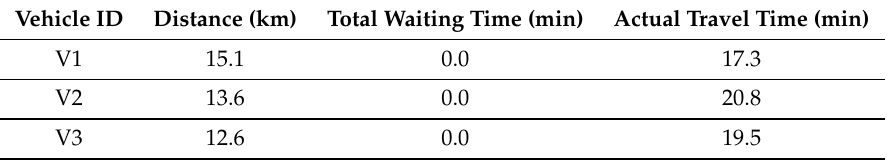
Table 2. Calculated results of scenario